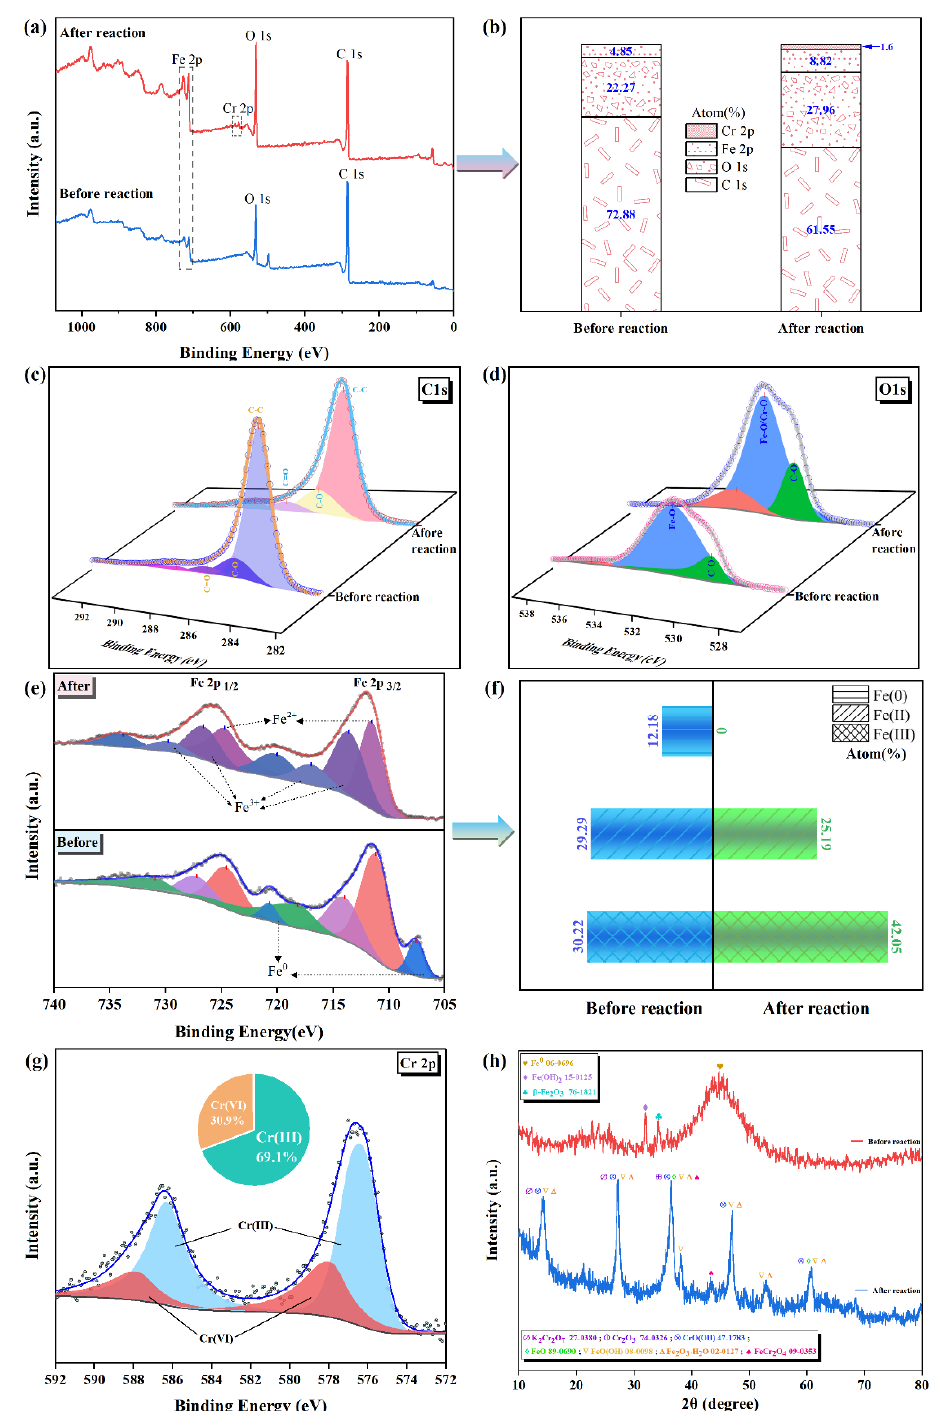
Figure 7. XPS spectra of RBC600-nZVI prior and post reactions with Cr(VI). ( a ) The full survey, ( b ) Content change of the surface atomic ratio of RBC600-nZVI before and after reaction with Cr(VI); ( c ) C 1s ( d ) O 1s and ( e ) Fe 2p binding state gradients; ( f ) The change of the specific content of iron in various valence states before and after the reaction of RBC600-nZVI with Cr(VI); ( g ) XPS spectra of Cr 2p after reaction with Cr(VI); ( h ) The XRD analysis of RBC600-nZVI before and after reaction with Cr(VI).